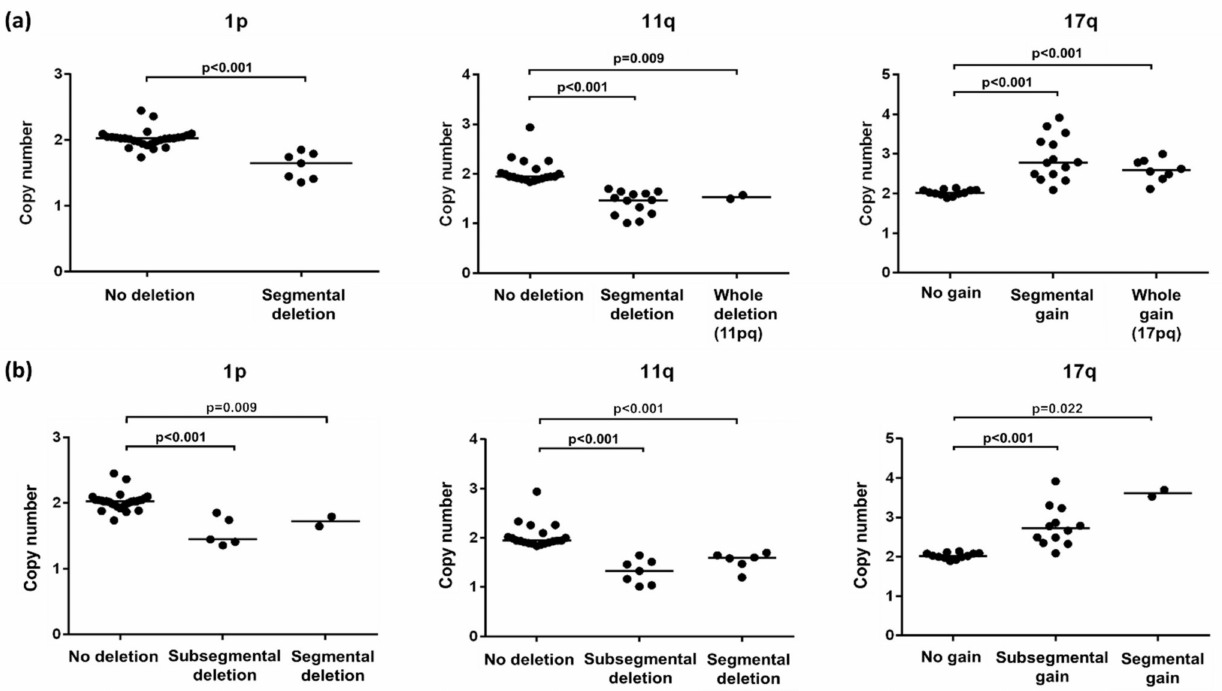
Figure 4. Comparison of copy numbers among SCA, no SCA, whole chromosome alteration ( a ), and among subsegmental, segmental chromosome alteration and whole chromosome alteration ( b ) by